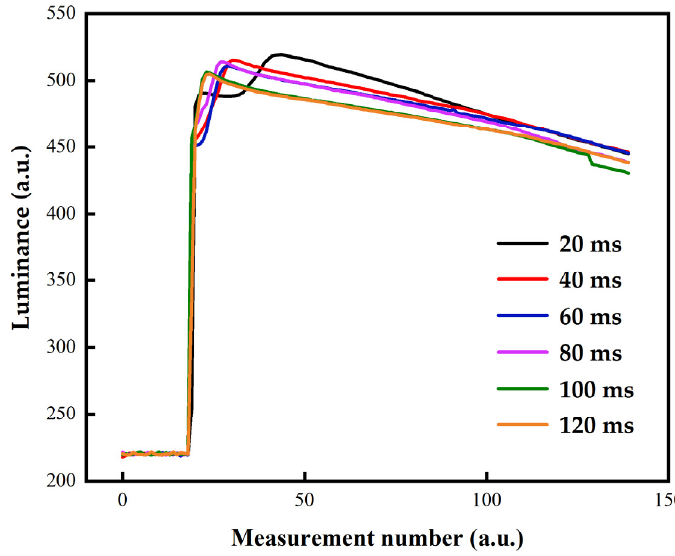
Figure 11. Luminance curves when the EWD was driven by voltages with different slopes of linear function. Oil splitting can be suppressed when T S 1 is set to 100 ms and 120 ms. T S 1 was set to 100 ms for a short response time.